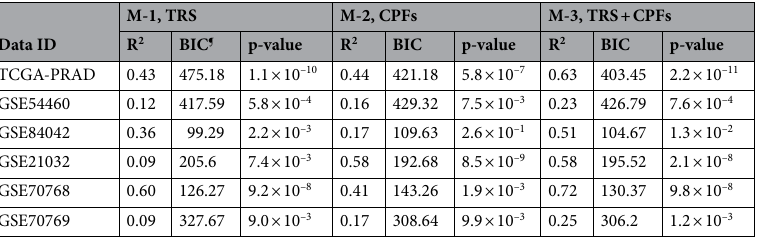
Table 3. Results from Cox regression model analysis. ╫ ╫ The three models (M-1, M-2 and M-3) are specified by the included predictor variable(s) for cancer relapse-free survival. TRS: transcriptomic risk score. CPFs: clinicopathologic prognostic factors. See the main text for a more detailed description. ¶ BIC: Bayesian Information